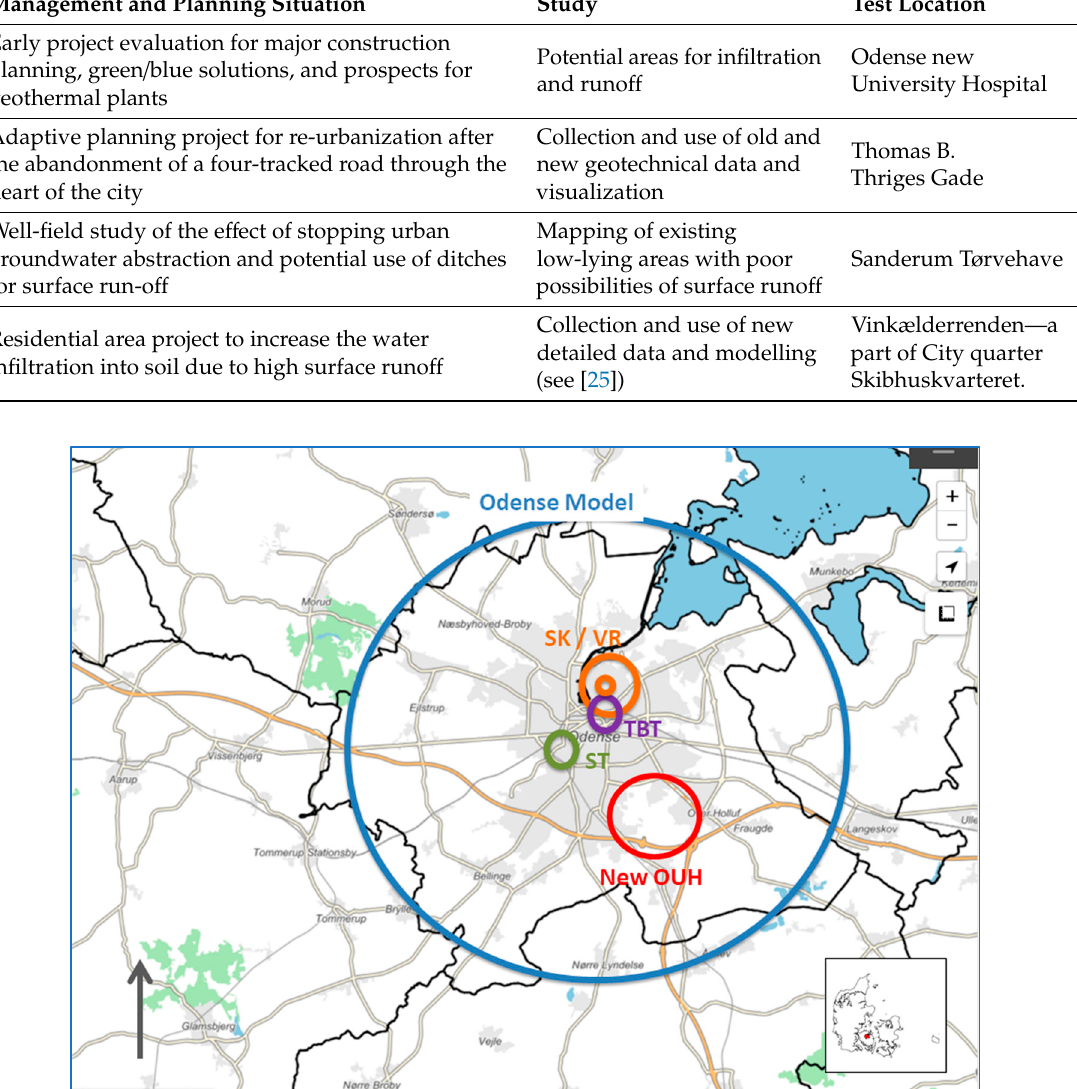
Figure 5. Conceptual frame for the hydrodynamic municipality model [25,29]: Yellow layer indicates anthropogenic origin; blue line is estimated hydraulic groundwater level, and red box indicates a detailed modelling area. Scale in meters. The second case-study focuses on hydrogeological modelling beneath cities. The existing data from Odense city revealed areas with only limited or old data (see Figure 6). The lack of sufficient